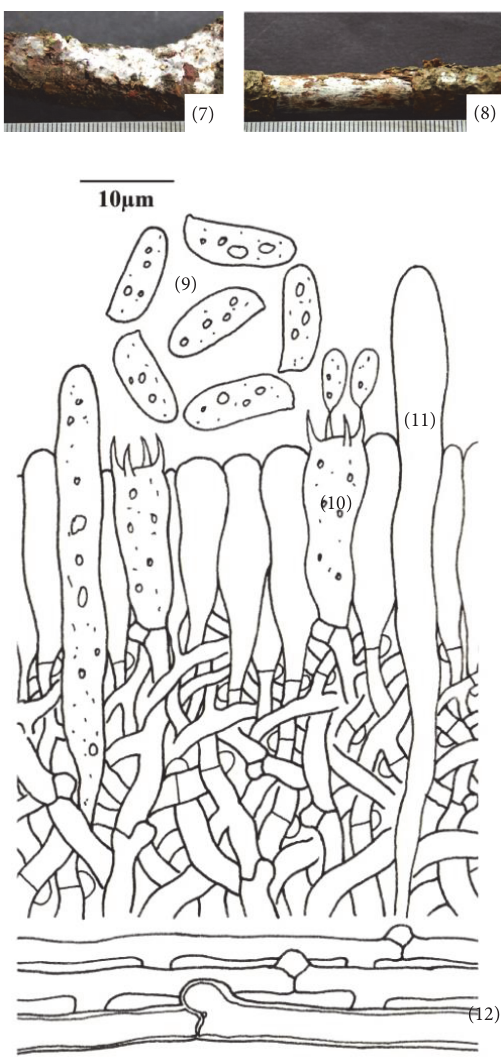
Figure 2: Hyphoderma definitum (7)–(12). (7) Fresh basidiocarp, (8) dried basidiocarp, (9) basidiospores, (10) basidium, (11) cystidium, and (12) generative